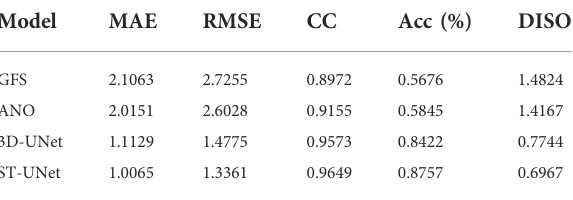
TABLE2Theoverallperformanceofmulti-timebiascorrectionforthe 2-m temperature on the test